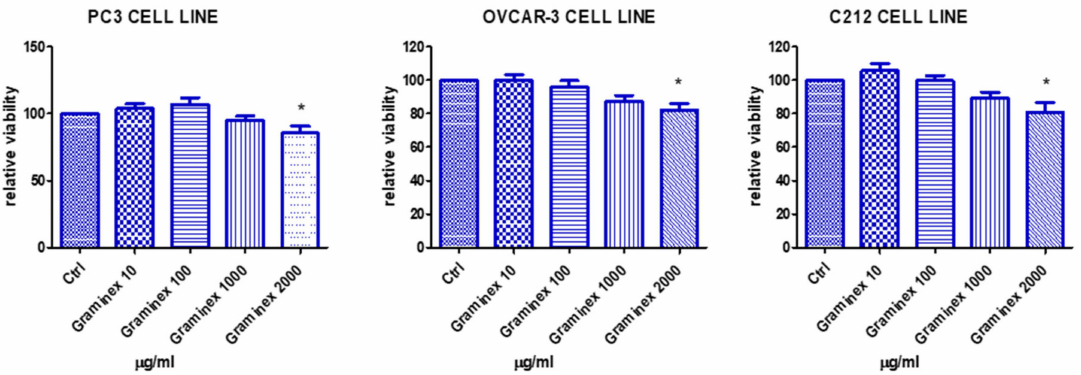
Figure 2. Effects of the extract on human prostate cancer PC3 cells, human ovary cancer OVCAR-3 cells, and the non-tumoral C2C12 myoblast cell line. At the highest tested concentration, the extract induced a mild reduction of cell viability in all tested cell lines (ANOVA, p < 0.05; * p < 0.05 vs. ctrl group). However, the cell viability was always over 70% compared to the respective ctrl group; thus, suggesting biocompatibility in the concentration range 10–2000 µ g/mL. This range was considered as biocompatible for the subsequent ex vivo determination in the prostate and ovary tissues.